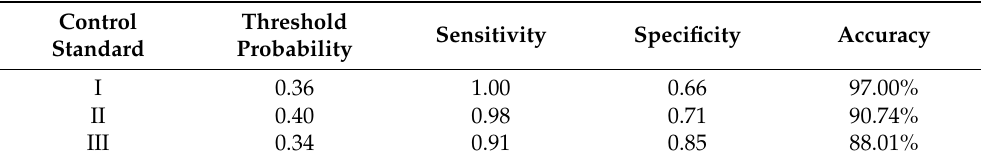
Table 2. Probability thresholds and model performances of the g sw status logistic models under the three control standards.